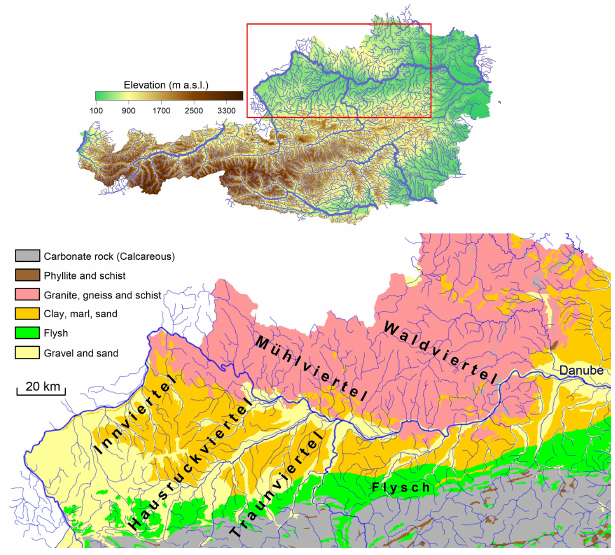
Figure 1. Location and geology of the pilot region in Austria and the subregions